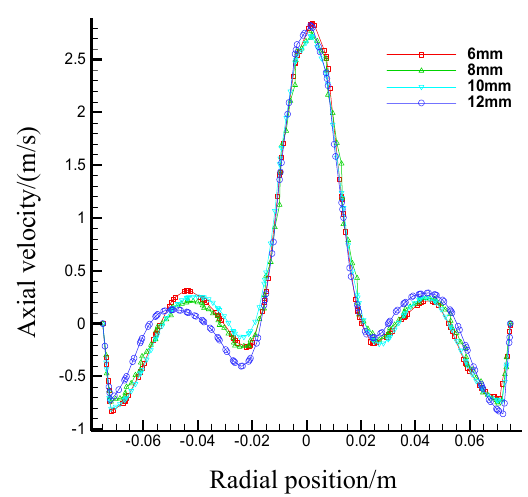
Figure 21. Axial velocity inside cyclone with different II underflow pipe.